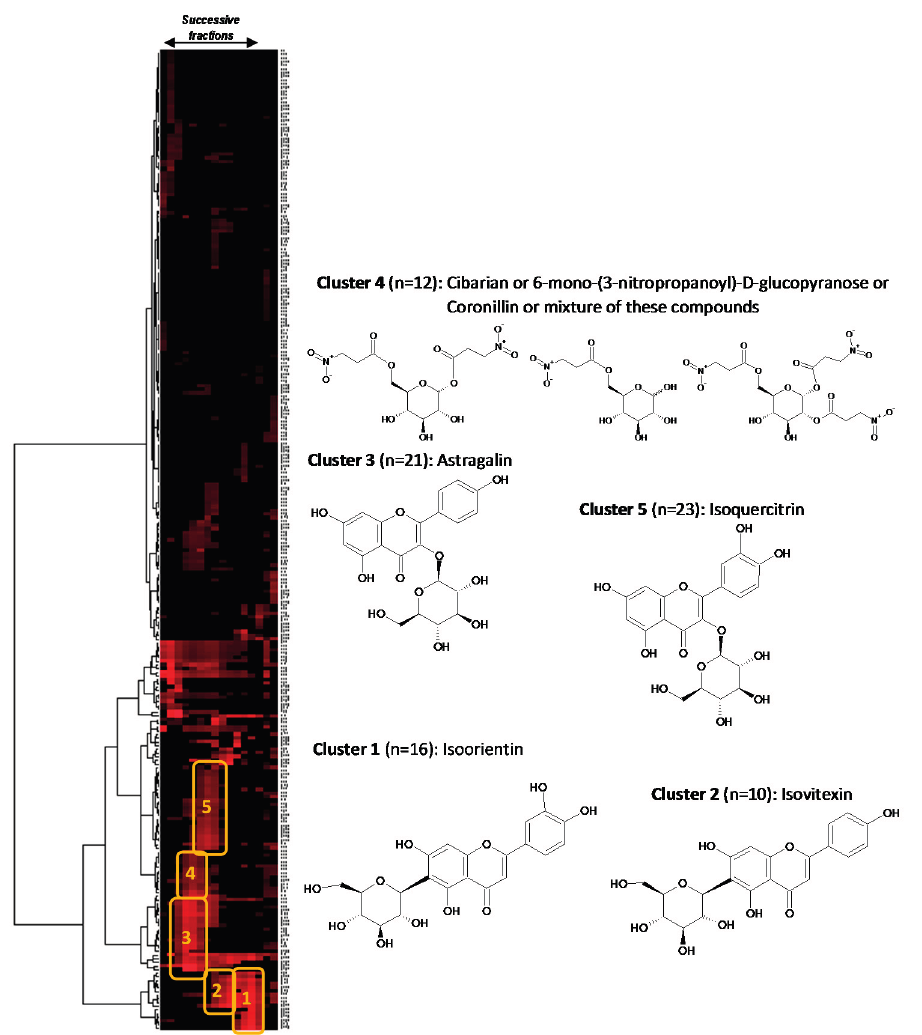
Figure 2. 13 C-NMR chemical shift clusters obtained by applying HCA on CPE